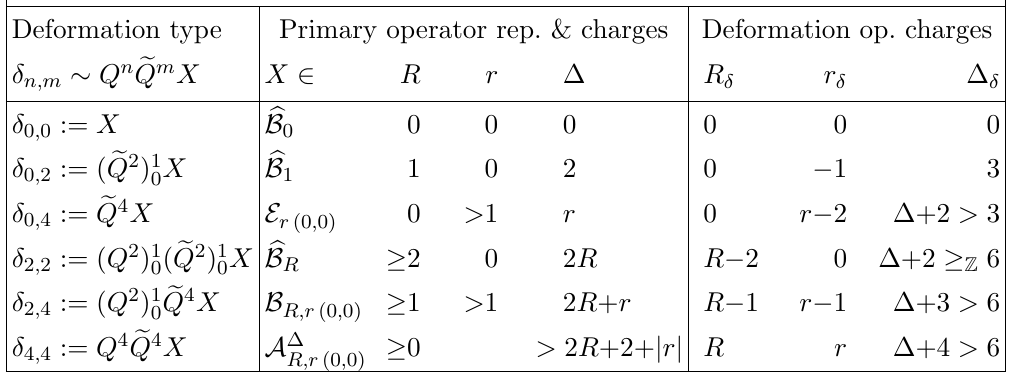
Table 3 . The quantum numbers ( R (cid:14) ; r (cid:14) ; (cid:1) (cid:14) ) of local operators preserving that can deform an = 2 SCFT, along with the representation and quantum numbers ( R; r; (cid:1)) of N the primary (cid:12)eld, X they are descended